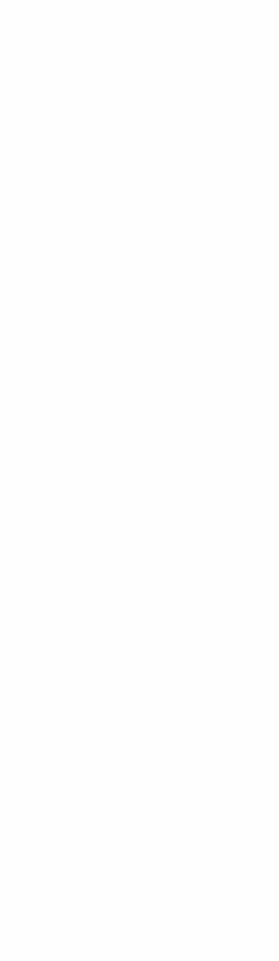
Tabe/le 1: Stationiire Grenzfliichen­ spannung der Tropfenfluide gegeniiber SilikoniH (AK-Oie) 25°C Table 1: Stationary surface tension of the droplet fluid compared to silicone oil (AK-oil) at 25°C. disperse Phase dispersed phase Wasser/water